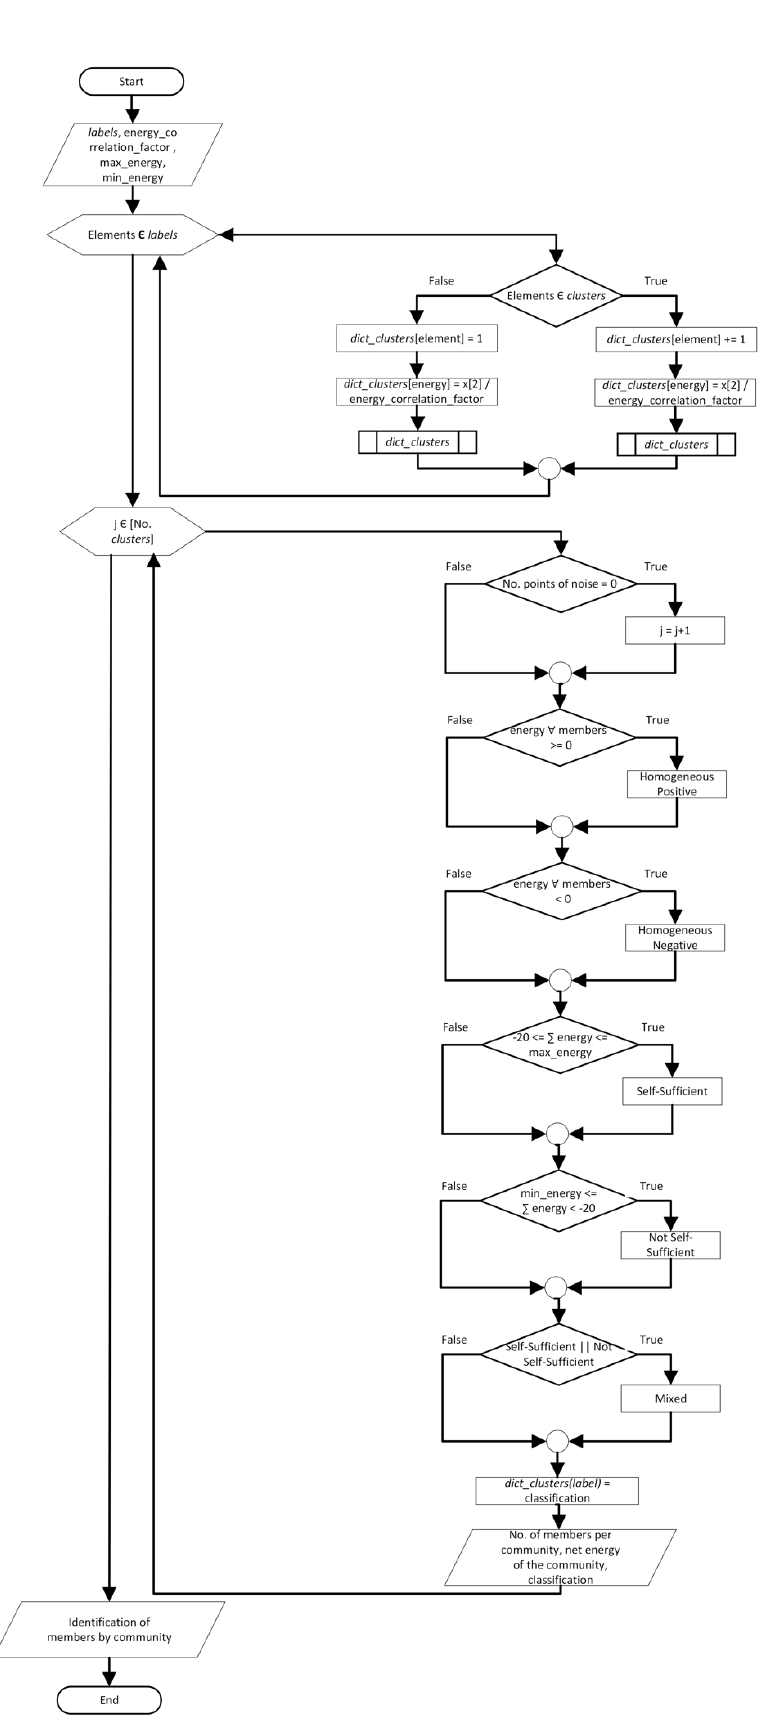
Figure 3. Flowchart of the classification model.